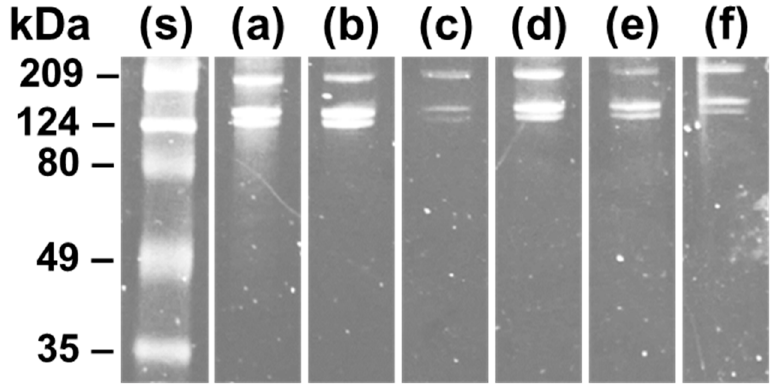
Figure 3. SDS-PAGE analysis of the protein markers (s), native collagen samples (a–c), and 4VBC- functionalised collagen samples (d–f). (a) BA; (b) PA; (c) CRT; (d) B-4VBC; (e) P-4VBC; (f) R-4VBC. Along with CD spectroscopy and SDS-PAGE, ATR–FTIR was employed to further confirm the collagen conformation in the native, functionalised, and UV-cured